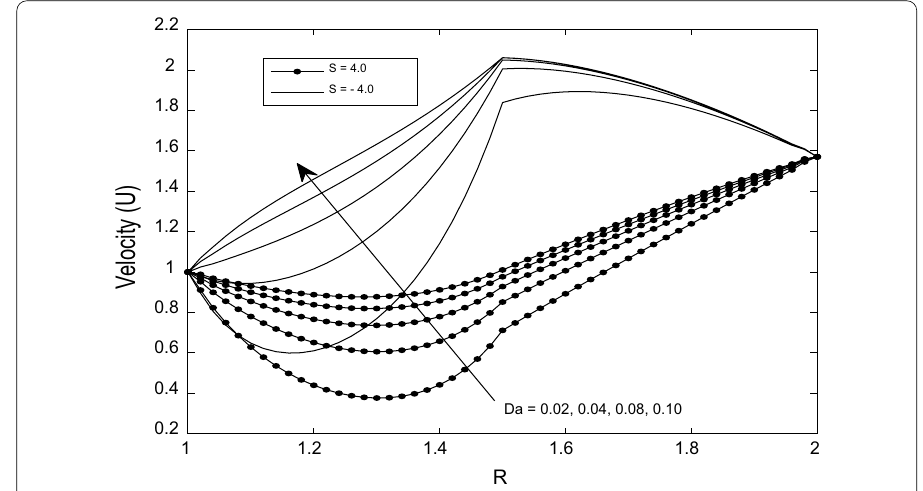
0.2, P 10, β 0.2, d 1.5, A ∗ 1, w 0.8 ) = = = − = = =